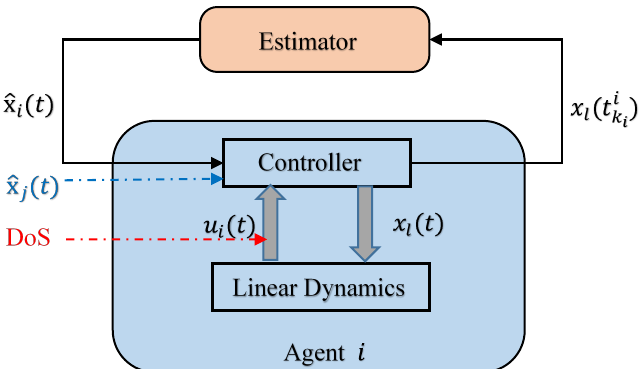
Figure 2. The event-triggered controller with an estimator under DoS attacks. ˆ x j ( t ) and ˆ x i ( t ) represent the estimates of agent j and agent i calculated by (7) and (8), respectively. x j ( t j the triggering time t i , where t i is determined by the trigger function (11). Under the influence of k i k i DoS attack, (11) can be triggered by the system, so as to update the state estimated value according to (8) and adjust the control signal on the basis of